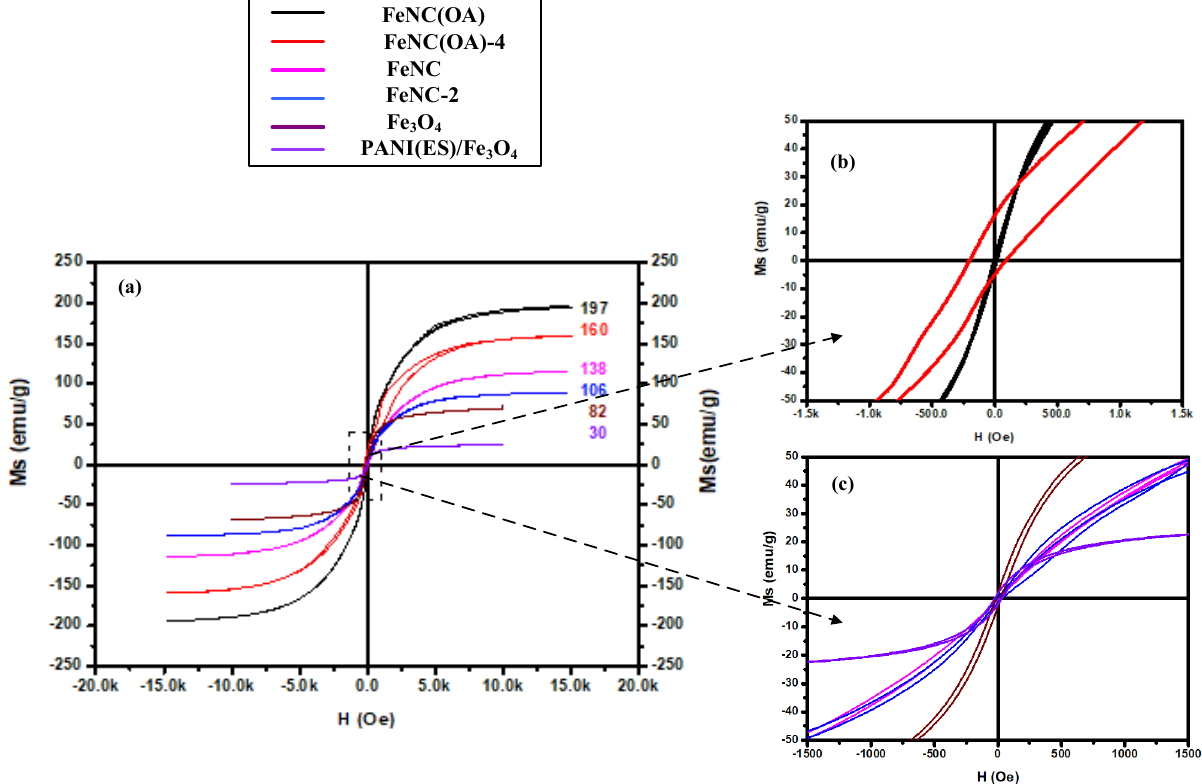
Figure 9. ( a ) SQUID curves for various iron compounds. ( b , c ) are enlarged insets of ( a ),